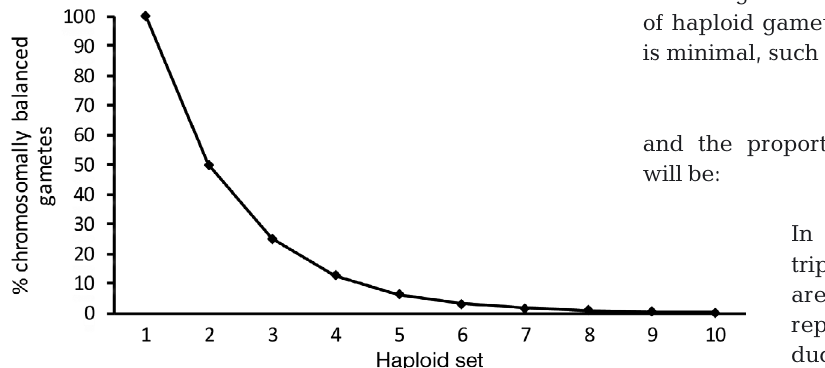
Fig. 1. Proportion of chromosomally balanced gametes (haploid and diploid) produced by triploid individuals as a function of the haploid number of the